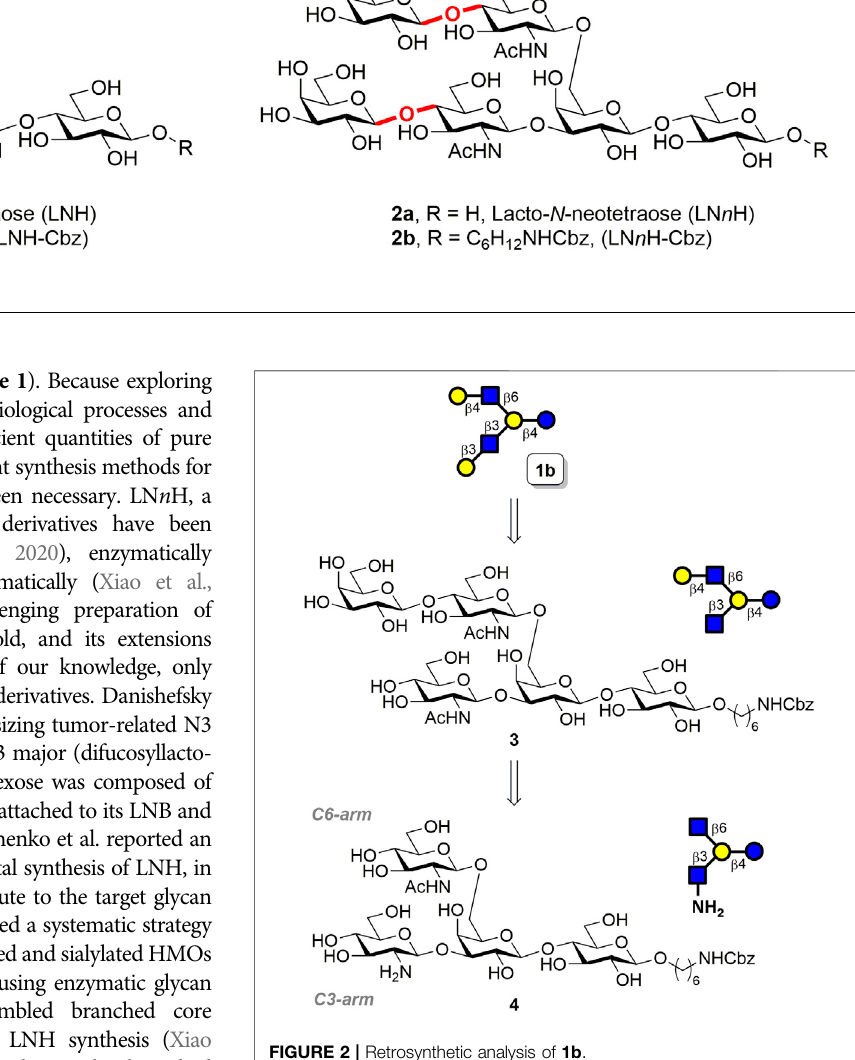
FIGURE 2 | Retrosynthetic analysis of 1b